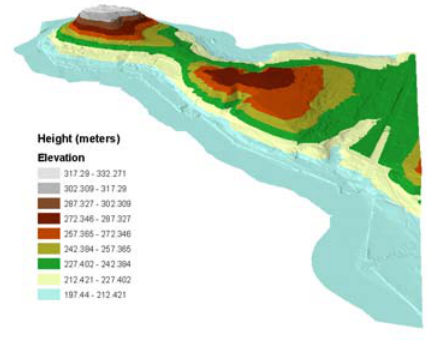
Figure 1. The original DTM